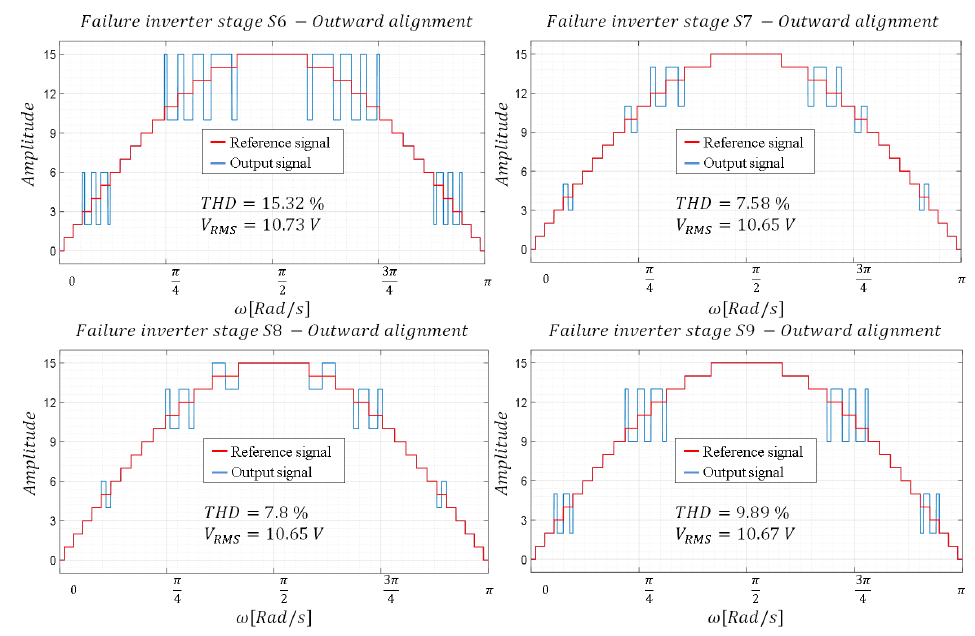
Figure 5. Waveforms—Configuration with a pulse and outward alignment.